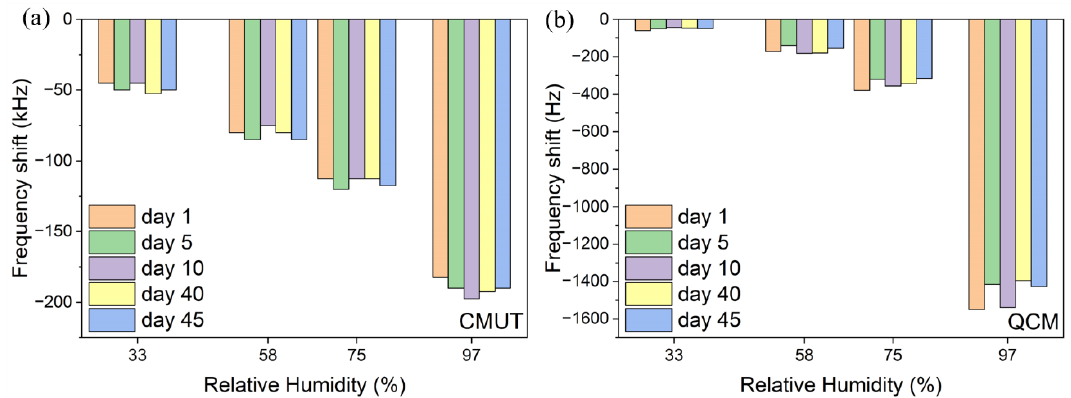
Figure 10. Frequency shifts of the CMUT and QCM sensors as a function of temperature.